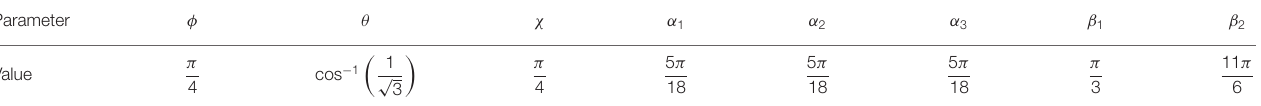
TABLE 1 | Parameter values for an optimal unitary operator U opt . Parameter φ